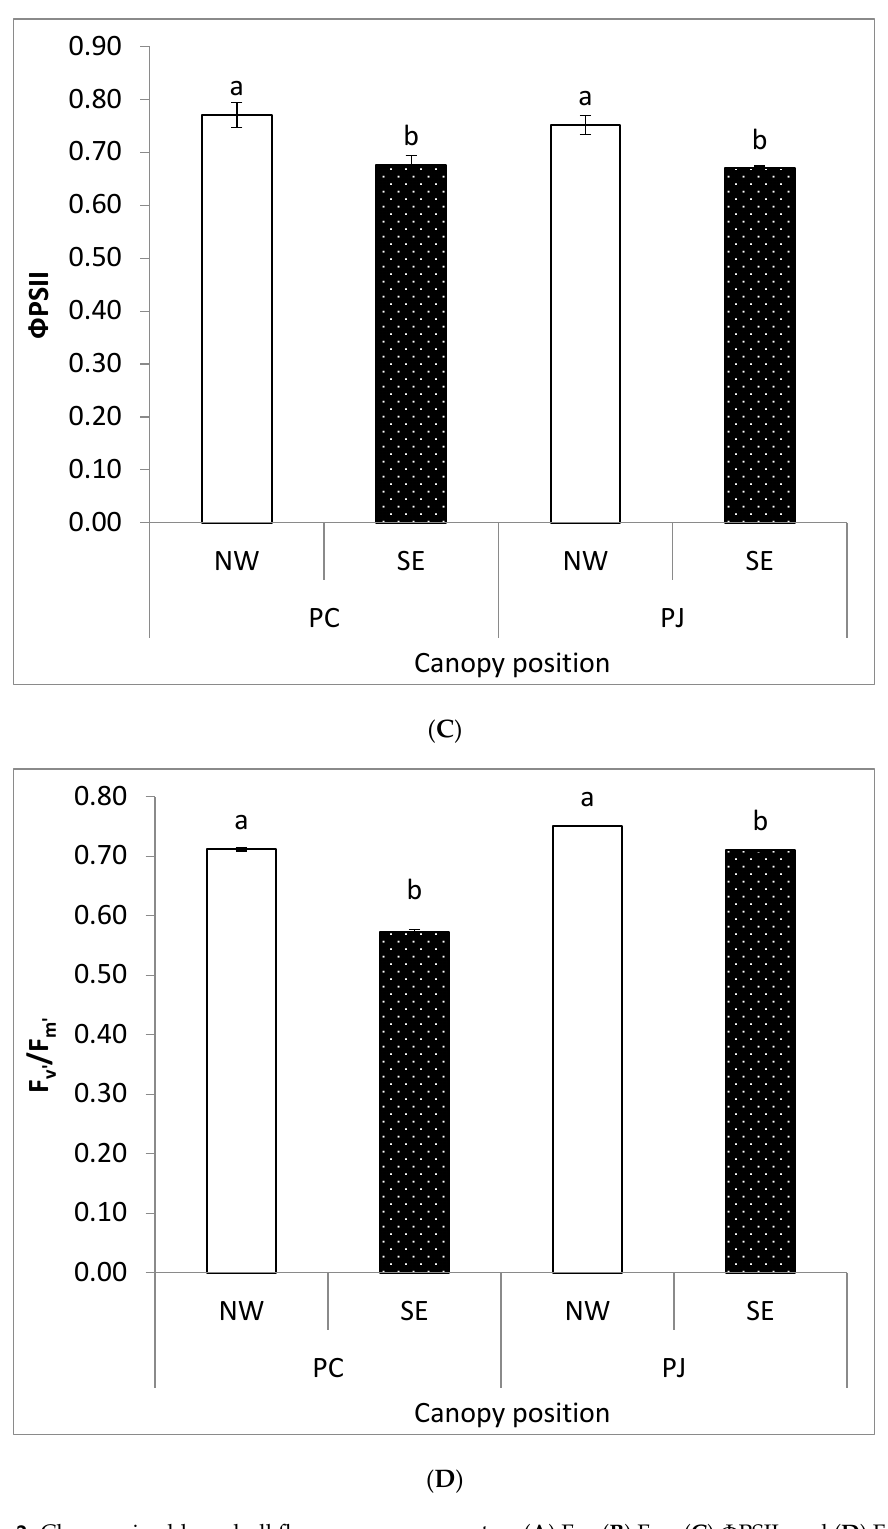
Figure 2. Changes in chlorophyll fluorescence parameters ( A ) F v’ , ( B ) F m’ , ( C ) ΦPSII, and ( D ) F v’ /F m’ in Prosopis juliflora and Prosopis cineraria , respectively, from two different canopy positions (south east, SE; north west, NW). Each bar in a graph represents the mean (±S.E.) of three replicates. Means with the same letters within a species indicate insignificant difference between the two canopy positions at p > 0.05 according to Duncan Multiple range test.